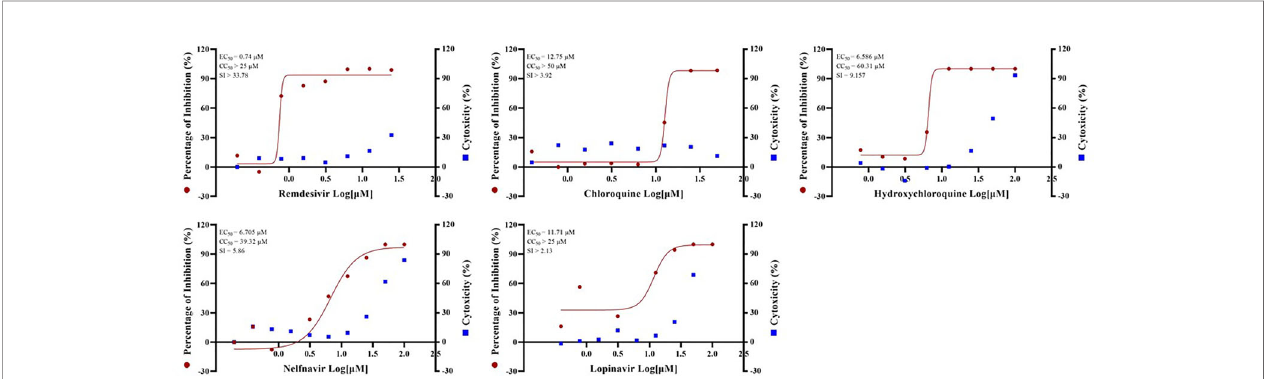
FIGURE 1 | EC 50 and CC 50 of remdesivir, chloroquine, hydroxychloroquine, nel fi navir and lopinavir for GX_P2V. Vero E6 cells were infected with GX_P2V at an MOI of 0.01. Using different doses of remdesivir, chloroquine, hydroxychloroquine, nel fi navir and lopinavir for treatment. After 72 hours, cells were collected and total RNA was extracted, and virus yield was quanti fi ed by qRT-PCR. Cytotoxicity of these drugs to Vero E6 cells was measured by CellTiter-Blue ® Cell Viability Assay (Promega). The left and right Y axes of the graph represent the average percentage of inhibition of virus yield and drug cytotoxicity, respectively. The experiments were performed in